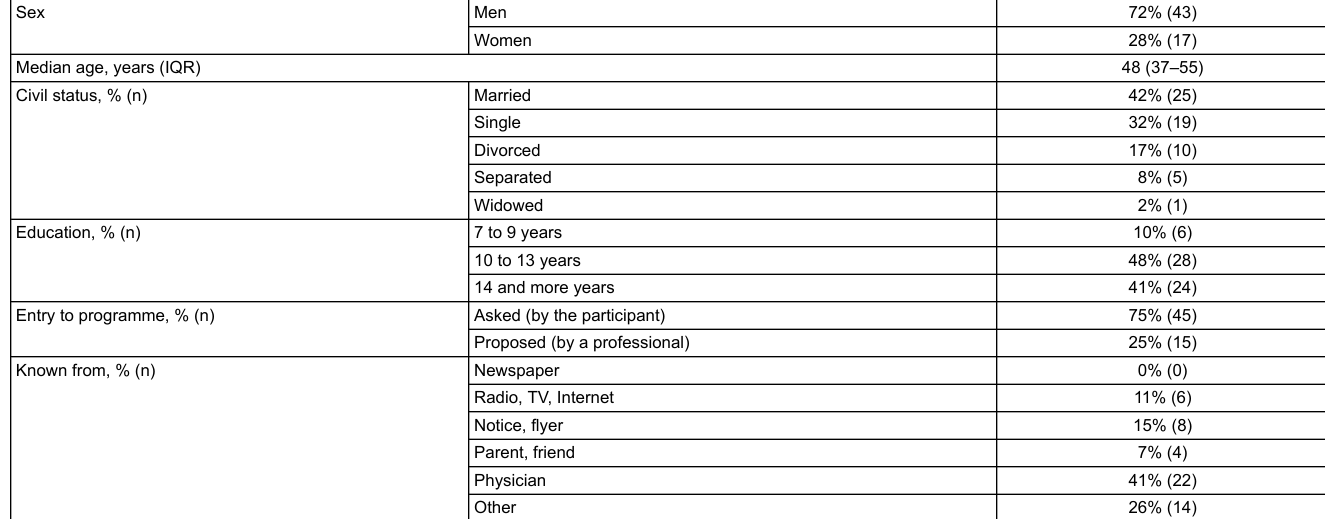
Table 1: Sociodemographic characteristics at baseline.